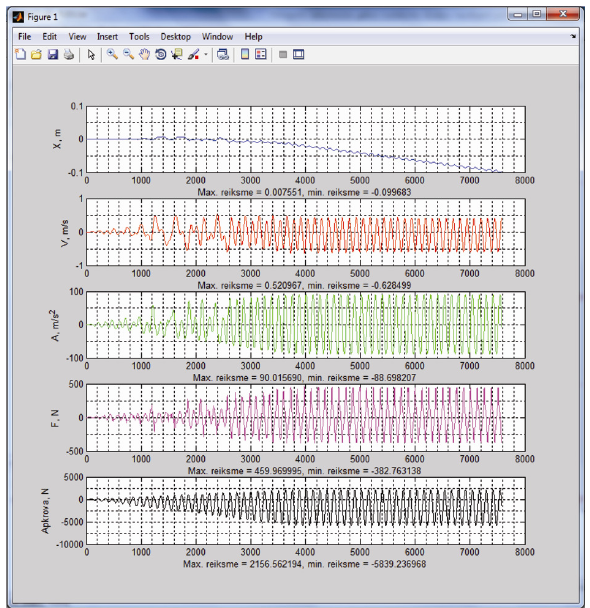
Fig. 7. Result plot